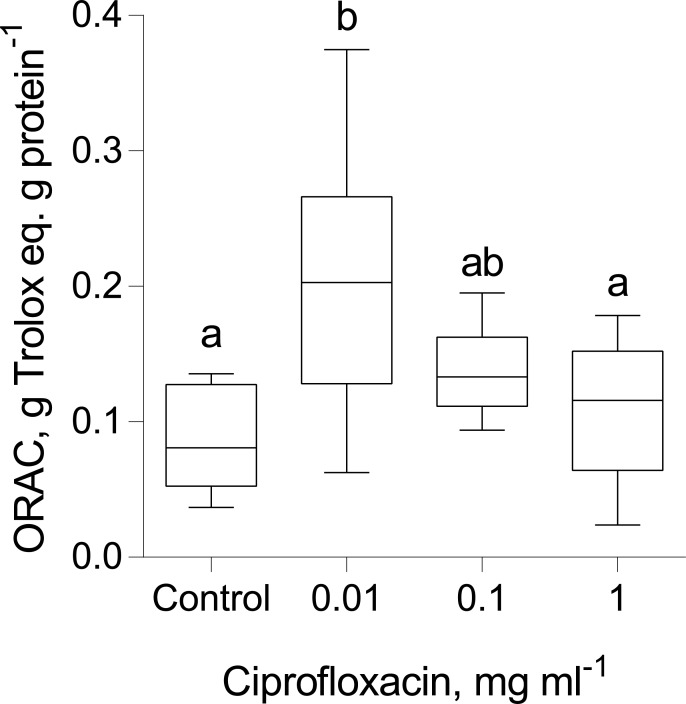
Daphnia magna: response of the total antioxidant capacity assayed as ORAC to the Ciprofloxacin concentration in the exposure.The individuals sampled after their fourth clutch were excluded for the ORAC (g Trolox eq. g protein-1) measurements, because some of them contained eggs in the brood chamber, which may affect the ORAC values. The non-matching letters indicate significant differences between the groups (Tukey's multiple comparisons test; p < 0.05). See Table 5 for the details on the statistical comparisons.